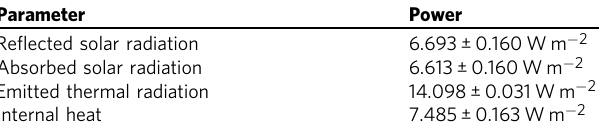
Table 1 Jupiter ’ s radiant energies and internal heat Parameter Power Re fl ected solar